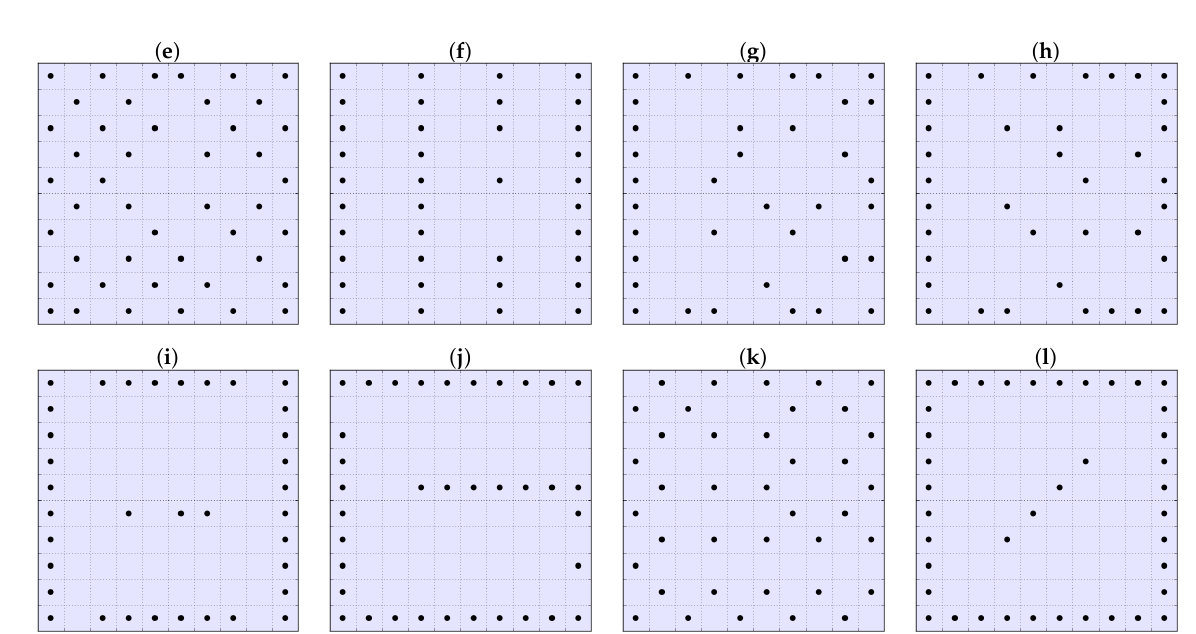
Figure 10. Reported optimal wind farm layouts for Case 2. ( a ) Present (SO). ( b ) Present (MO). ( c ) Mosetti et al. [3]. ( d ) Grady et al. [7]. ( e ) Yang et al. [10]. ( f ) Emami et al. [9]. ( g ) Huang et al. [8] SG. ( h ) Huang et al. [8] DG. ( i ) Pookpunt et al. [11]. ( j ) Ulku et al. [13]. ( k ) Turner et al. [12]. ( l ) Yang et al. [14]. Table 4. Result comparison for case